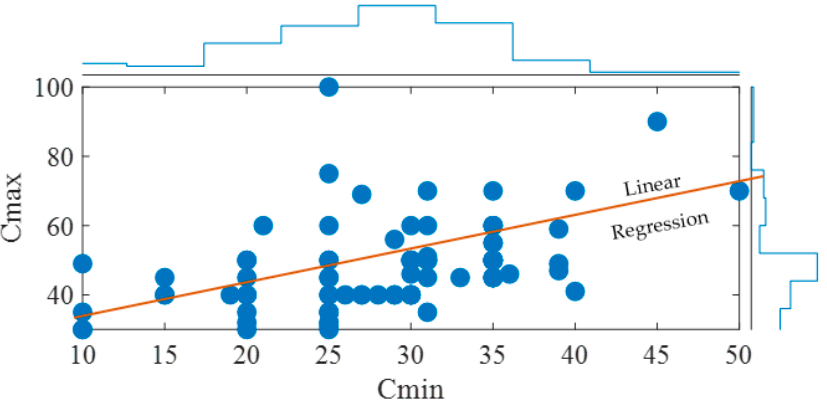
Figure 3. Distribution and correlation between the price levels C min and C max in [ct/kWh].